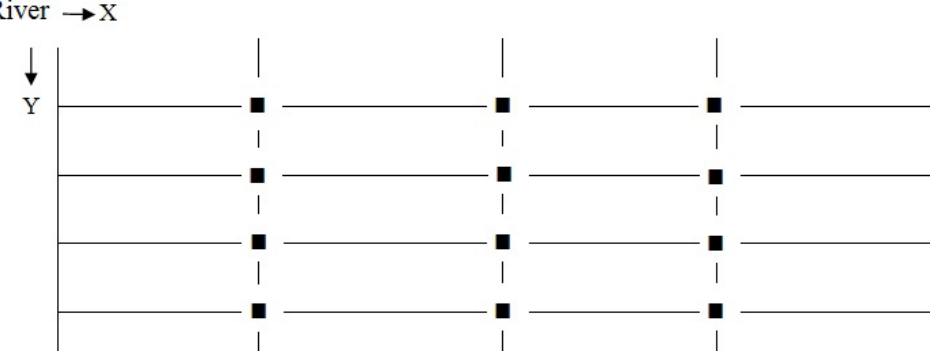
Figure 3. Soil sampling network in the two study areas; X and Y represent the sampling areas.